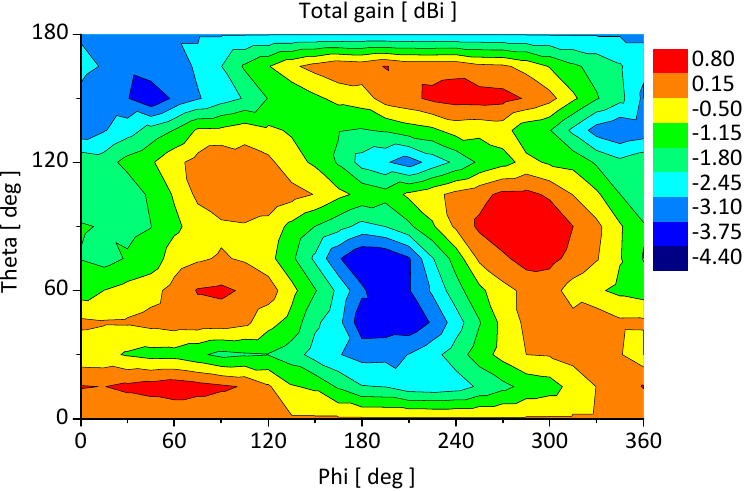
Figure 10. Measurement result of the gain deviation over the entire space.